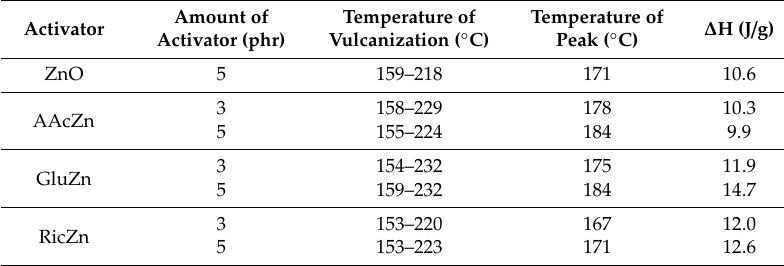
Figure 2. DSC curves of SBR compounds with 5 phr of varying activators.